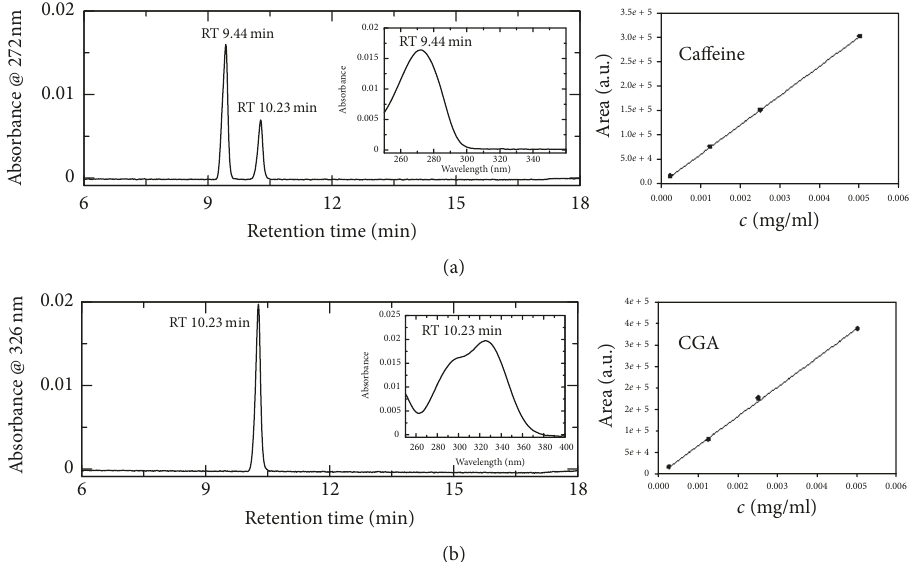
Figure 3: Chromatographic analysis for caffeine (a) and CGA (b). In the left the profiles of elution registered at the maximum of absorbance for caffeine or CGA as function of the retention time. The inset shows the spectrum at the maximum of peak. In the right, the calibration curves obtained by plotting the peak area as function of the concentration of injected sample. The lines represent the linear fit.